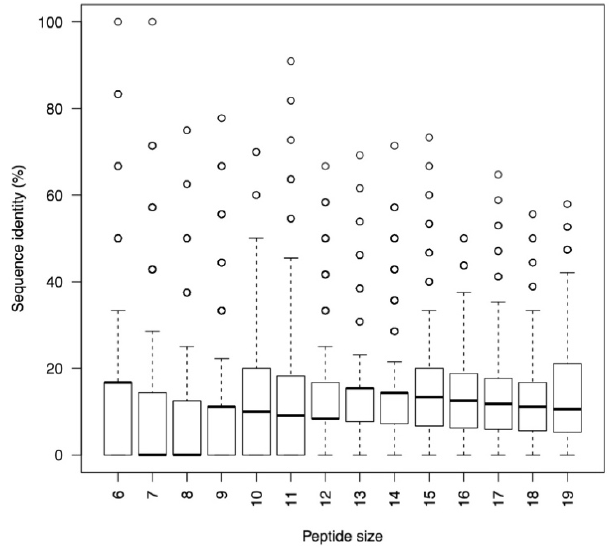
Figure 2. Box plot showing the distribution of sequence identity. 10,000 pairs of sequences of different sizes ( X -axis) designed to target the RBD of SARS-CoV and SARS-CoV-2 were selected randomly and aligned.